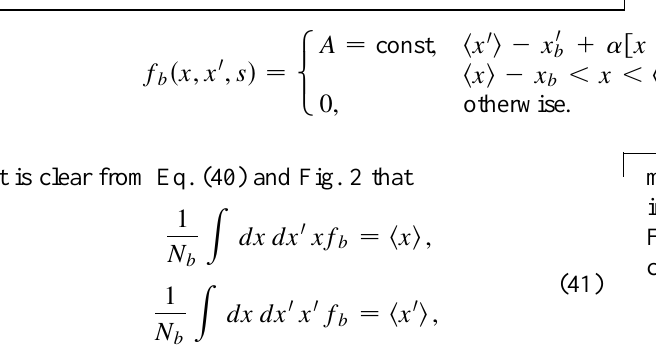
Fig. 2 that the density profile n b (cid:1) x , s (cid:2) (cid:1) corresponds to the simple step-function